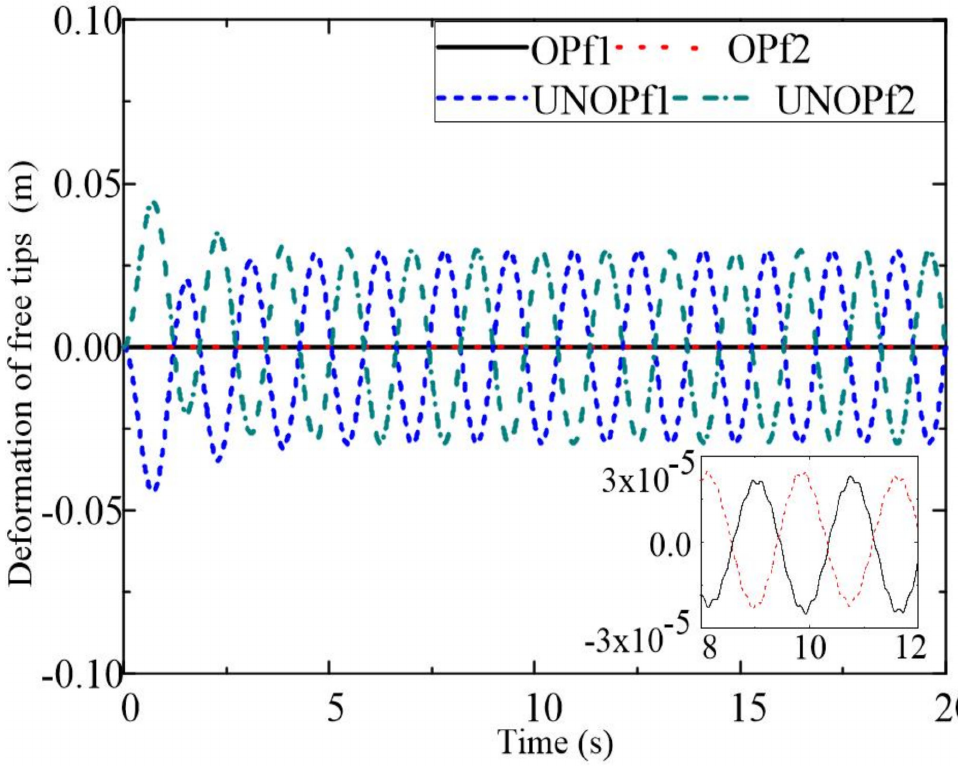
Figure 13. Deformation of the tips on the beams during the preassembly